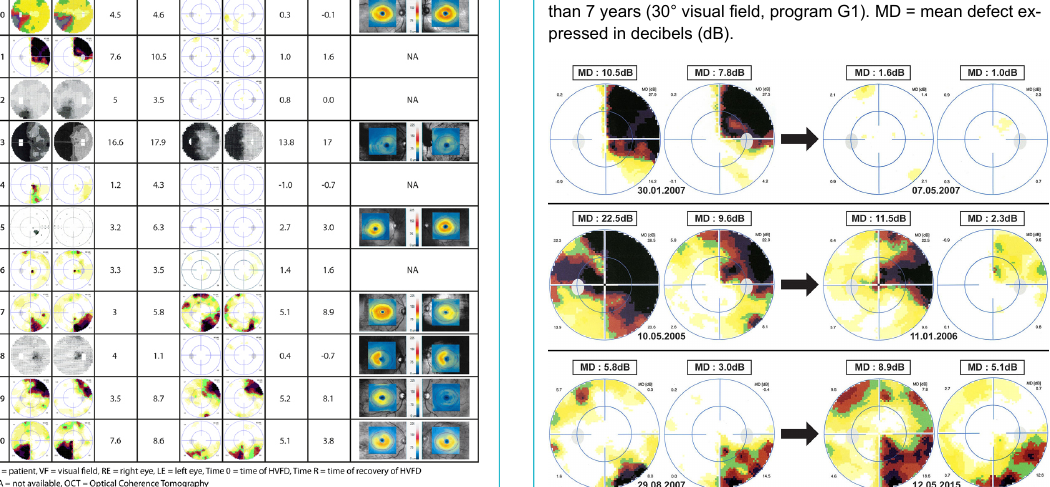
Figure 3: Examples of the types of evolution of homonymous visu- al field defects. Top – complete recovery of a right homonymous quadrantanopsia in 13 weeks (30° visual field, program G1). Mid- dle – partial recovery of a partial right homonymous hemianopia after 28 weeks (30° visual field, program G1). Bottom – no recov- ery of a right inferior homonymous quadrantanopsia after more than 7 years (30° visual field, program G1). MD = mean defect ex- pressed in decibels